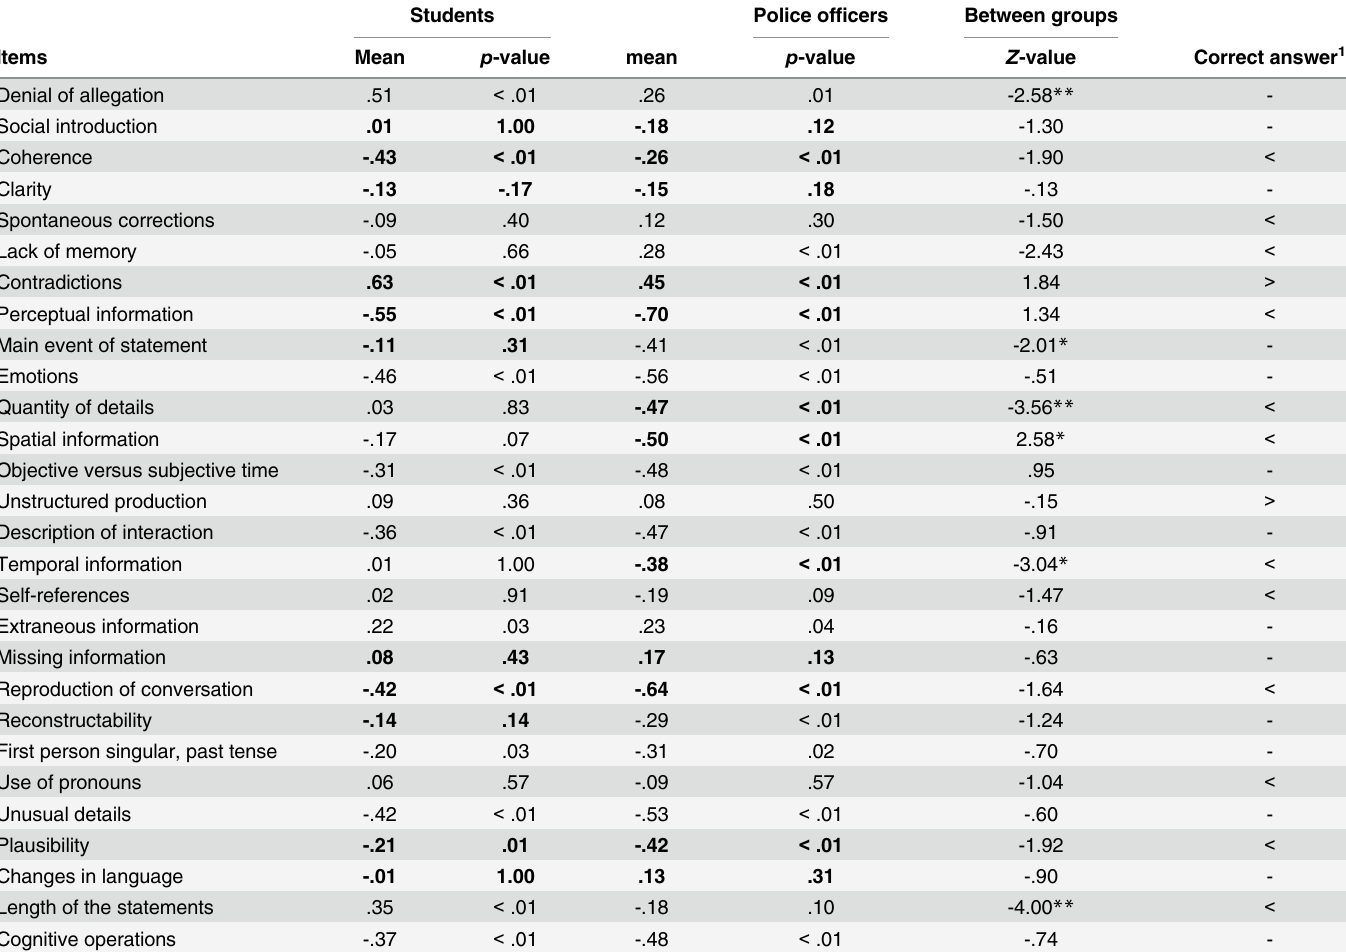
Table 4. Beliefs about verbal cues of students (n = 104) and police officers (n =